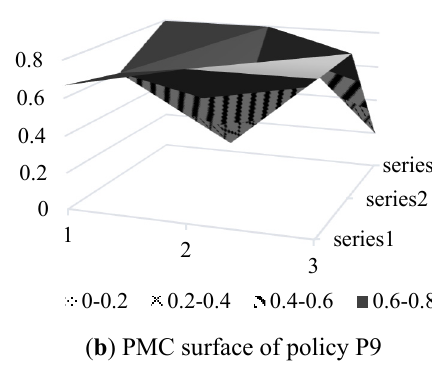
Figure 2. PMC surface of fishery insurance policy.